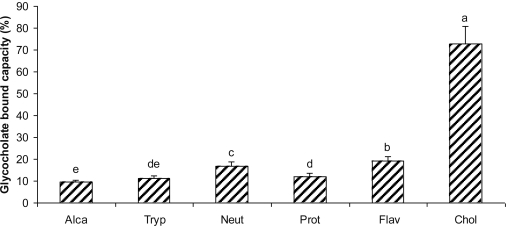
Sodium glycocholate binding by peptides from five differents hydrolysates of defatted corn protein. Alca: Alcalase; Tryp: Trypsin; Neut: Neutrase; Prot: Protamex; Flav: Flavourzyme. Cholestyramine (Chol) was used as a positive control. Different letters indicate significant differences (p < 0.05).